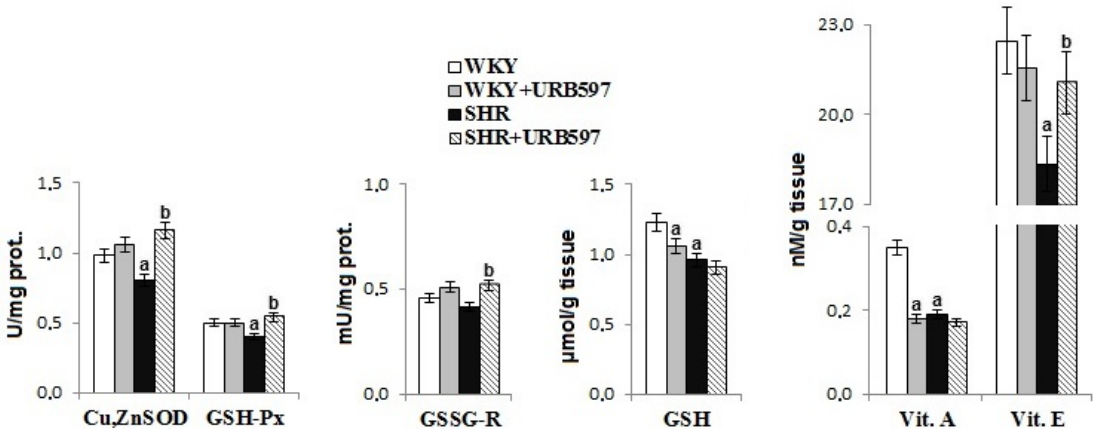
Figure 1. The activities / levels of antioxidant parameters in the brain of rats with spontaneous hypertension and hypertensive rats after URB597 administration. Data points represent the mean ± SD, n = 6; (a, significantly di ff erent from the Wistar–Kyoto (WKY) group, p < 0.05; b, significantly di ff erent from the of spontaneously hypertensive rats (SHR) group, p < 0.05).